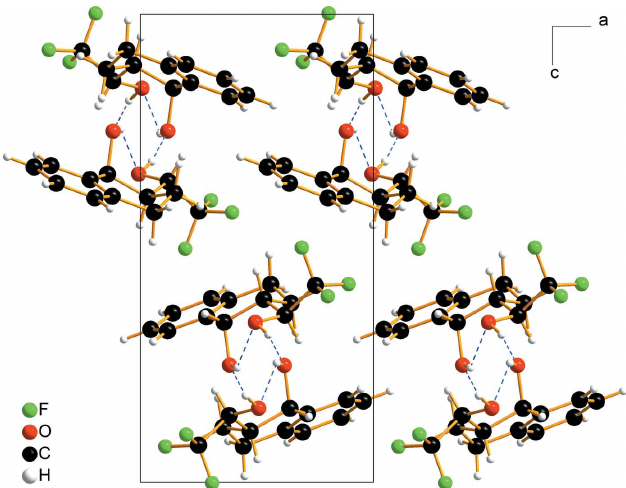
Figure 3 Molecular packing of the title compound viewed along [010]. The helical hydrogen-bonded chains are shown by blue dashed lines.